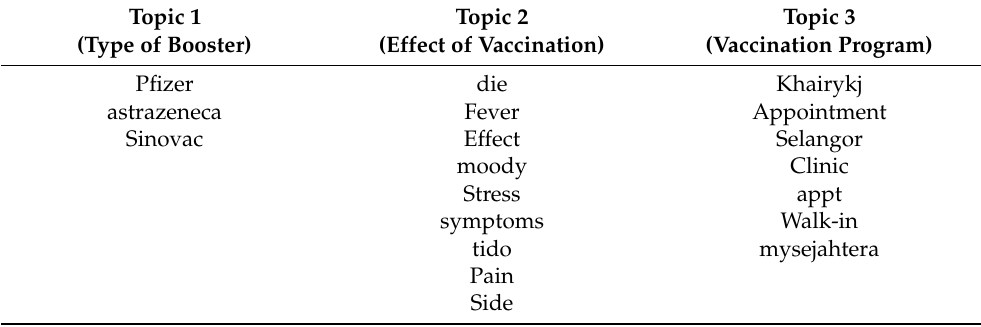
Table 1. Topics modeled from the tweets with LDA for the topic related to vaccine booster in Malaysia.